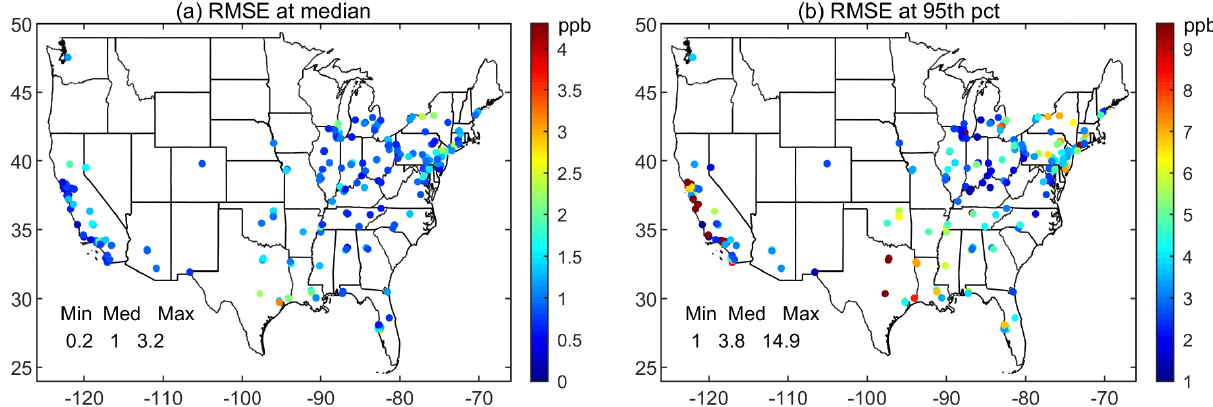
Figure 8. Errors in the 21 “pseudo-simulated” or reconstructed ozone time series with SY generated from modeled DM8HR ozone time series using BL obtained from observations at (a) the median and (b) 95th